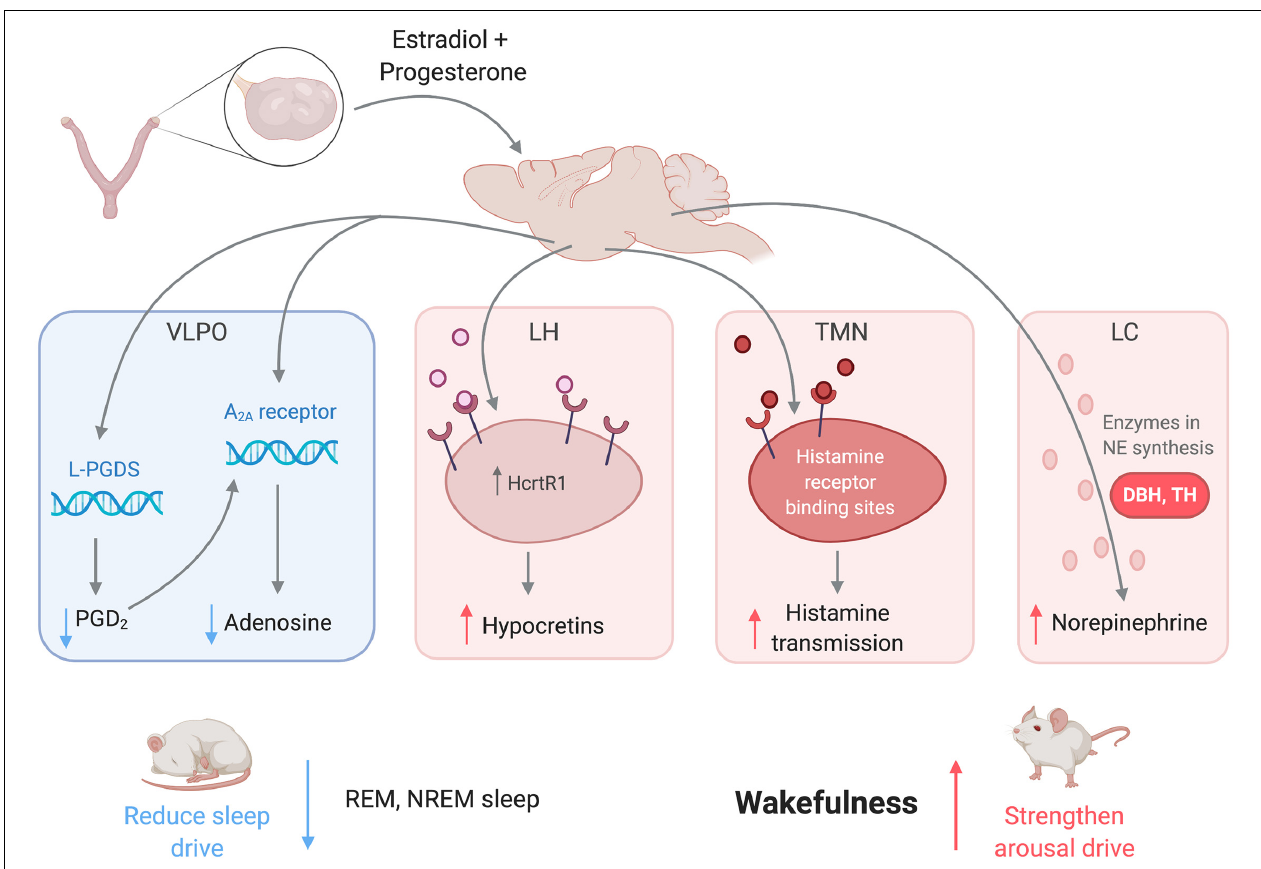
FIGURE 2 | Female sex hormones act on neural regions associated with sleep and wakefulness to promote arousal and suppress sleep. Estradiol and progesterone suppress neural transmission of somnogens in the VLPO, weakening the sleep drive. The hormones also increase transmission of arousal-promoting substances in the LH, TMN, LC, as well as other regions not pictured to strengthen the arousal drive. Abbreviations: VLPO, ventrolateral preoptic nucleus; L-PGDS, lipocalin-type prostaglandin synthase; PGD 2 , prostaglandin H 2 ; A 2 A , adenosine 2A receptor; LC, locus coeruleus; NE, norepinephrine; TMN, tuberomammillary nucleus; LH, lateral hypothalamus; HcrtR1, hypocretin receptor 1; REM, rapid-eye movement sleep; NREM; non-rapid-eye movement